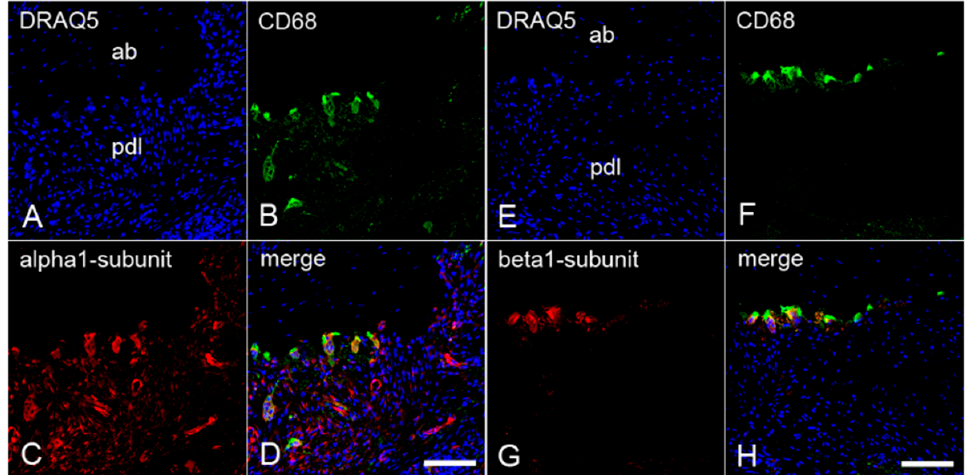
Figure 4. Colocalization of the α 1 - and β 1 -subunits of sGC with CD68 in osteoclasts of inflamed human periodontium: sections of a representative molar with adherent clinically inflamed periodontium were stained with DRAQ5 ( A , E ) and incubated with antibodies for CD68 ( B , F ), α 1 -subunit ( C ), and β 1 -subunit ( G ) of sGC. Colocalization of CD68 with the α 1 - subunit ( D ) and β 1 -subunit ( H ) in osteoclasts is depicted in the merged images. ab = alveolar bone, and pdl = periodontal ligament. Scale bar = 100 µm ( D , H ).